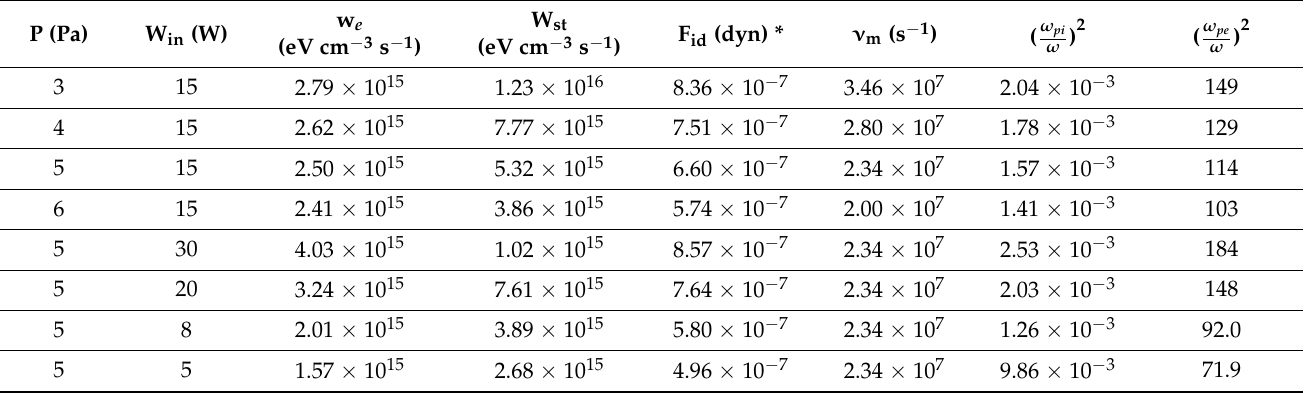
Table 5. Ion drag force, power of stochastic heating of electrons, transport frequency ( ν m ), and ratio of ion and electron plasma frequencies to the circular frequency of the RF discharge ω = 2 π × 13.56 MHz = 8.52 × 10 7 s − 1